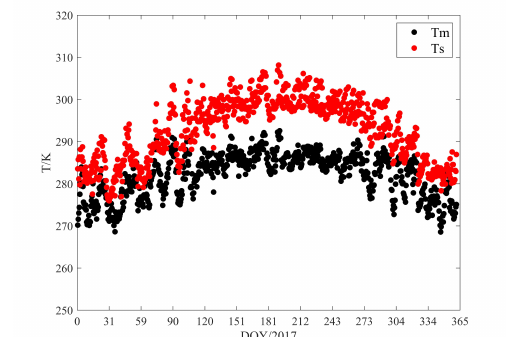
Figure 1. Time-space variation scatter plots of T m and T s According to the preliminary statistical analysis of the calculated data, the T m average value of Guilin radiosonde station in 2017 is 282.063 K, the average value of T s is 292.576 K. The variation of T m and T s with time shows a single peak curve and they have the similar trends where can be seen in Figure 1. The T m and T s values increase gradually from Jan to July, and reach the maximum in summer, then began to decline since Mid-July, finally reach the minimize in winter. On the whole, the four seasons change significantly. In addition, the T m values are lower than the T s values, and the difference